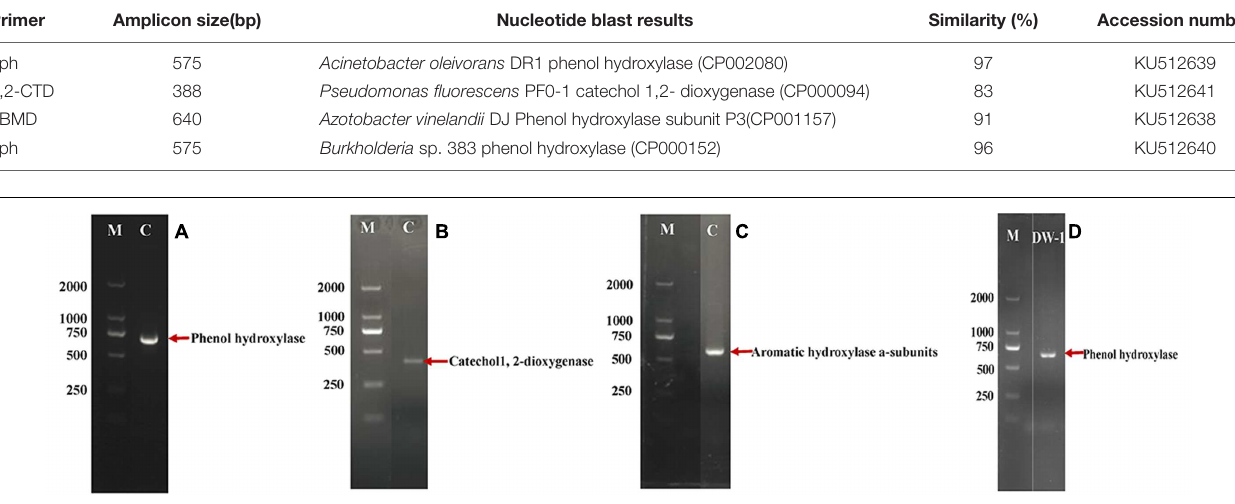
bacteria from the BAC layer in drinking water have a strong potential for phenol